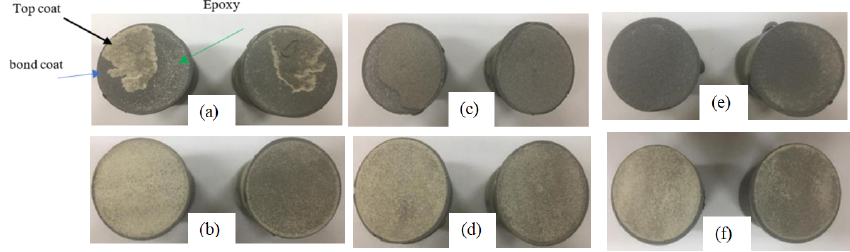
Figure 15: Fracture modes in adhesion test: fracture in the glued joint, and failure in the topcoat-bond coat interface; (a) head of cylinder substrate 500 µ m coat, (b) head of cylinder substrate 1000 µ m coat, (c) valve substrate 500 µ m coat, (d) valve substrate 1000 µ m coat, (e) piston substrate 500 µ m coat and (f) piston substrate 1000 µ m coat